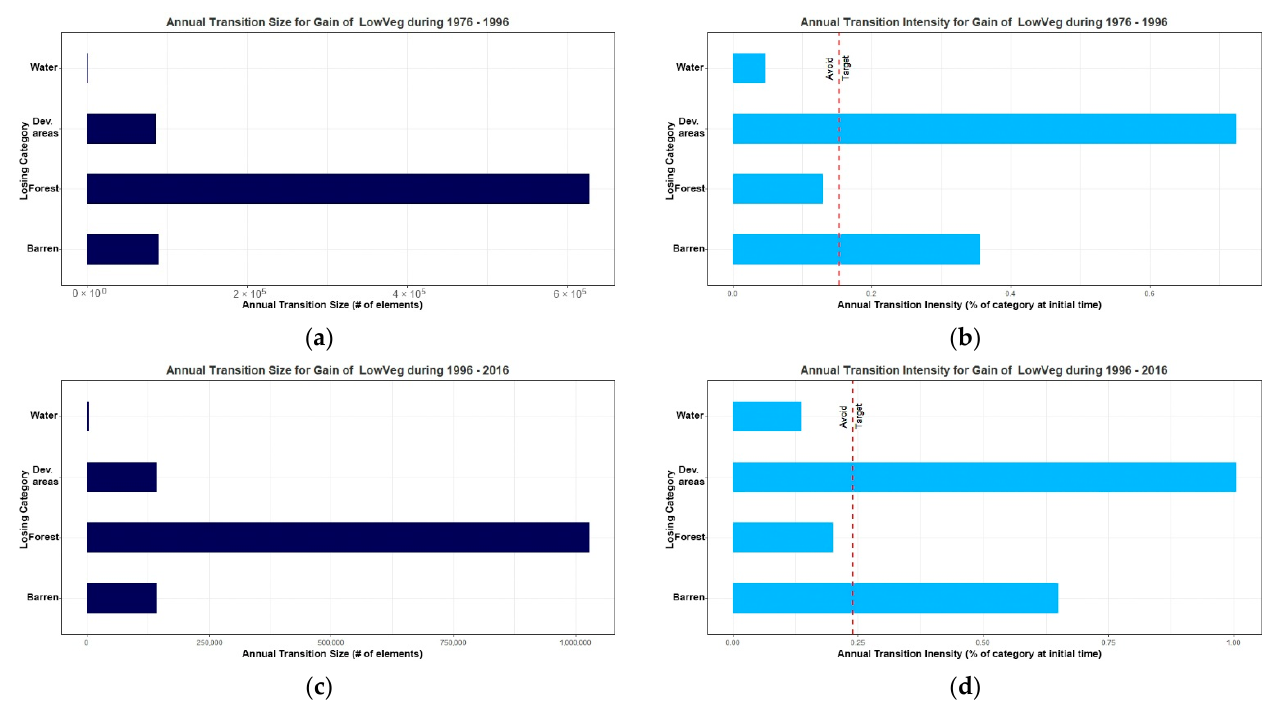
Figure 13. Annual gain transitions of low vegetation class during 1976–1996 and 1996–2016; ( a ) annual transition size for gain of low vegetation during 1976–1996; ( b ) annual transition intensity for gain of low vegetation during 1976–1996; ( c ) annual transition size for gain of low vegetation during 1996–2016; annual transition intensity for gain of low vegetation during 1996–2016 ( d ).